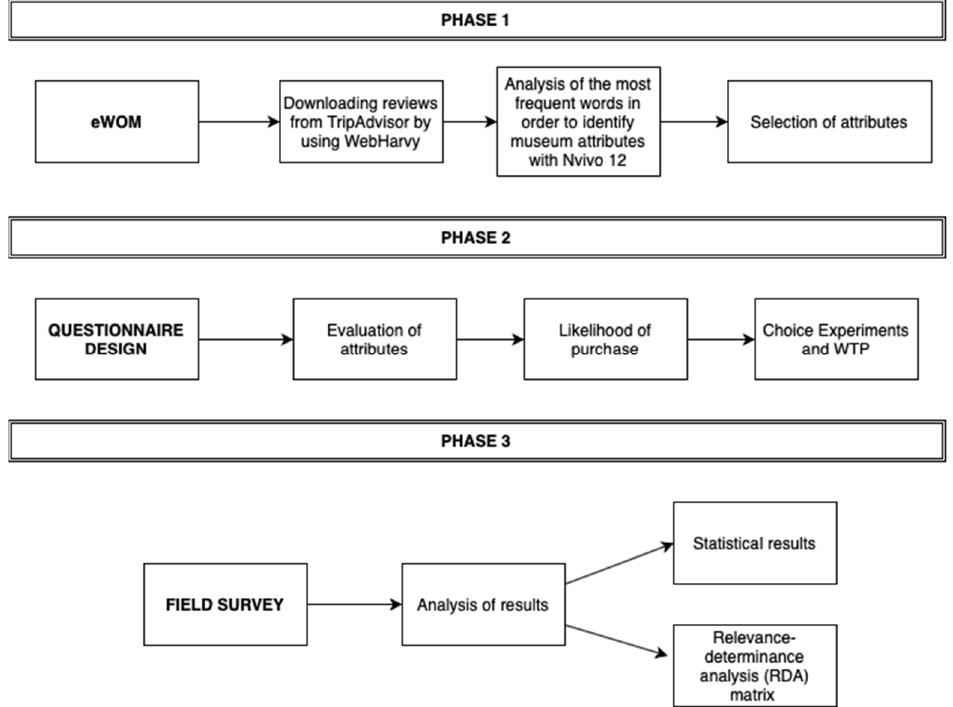
Figure 3. Methodological approach.